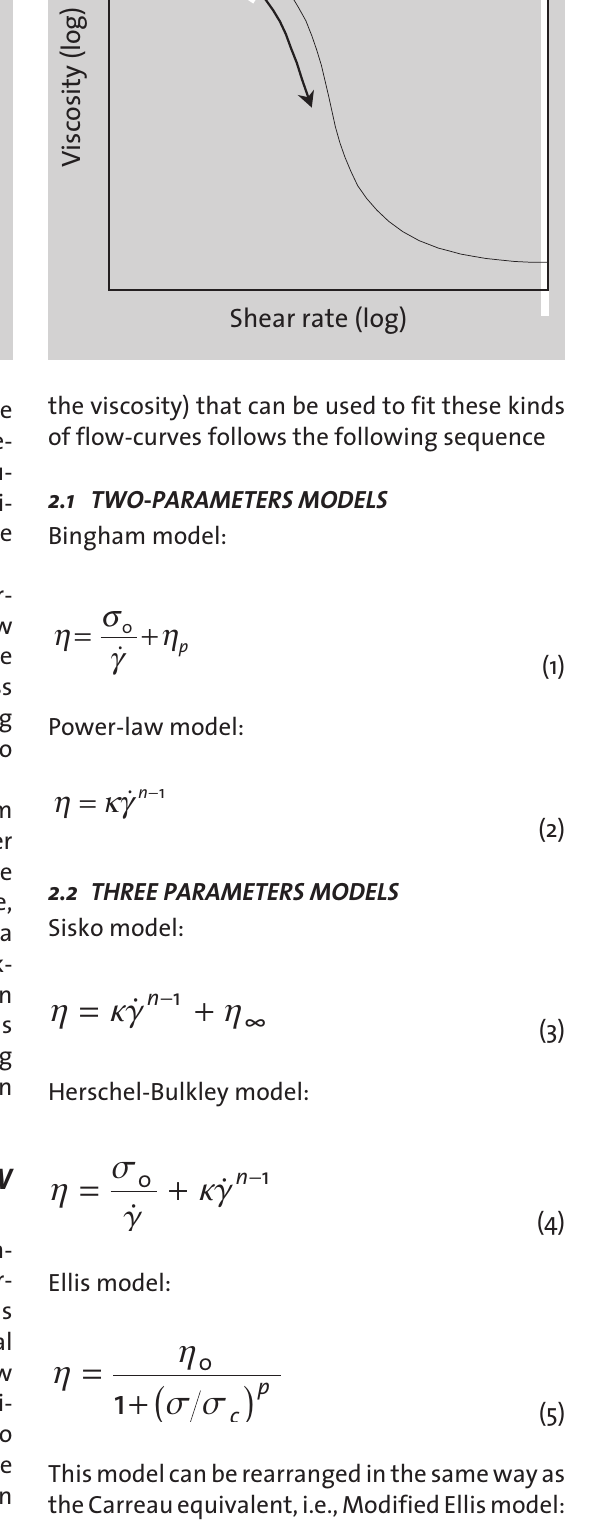
Figure 1 (left): Schematic diagram of the range of the various flow models for viscosity/shear-rate data. Figure 2 (right): Schematic diagram of the range of the various flow models for viscosity/shear-stress